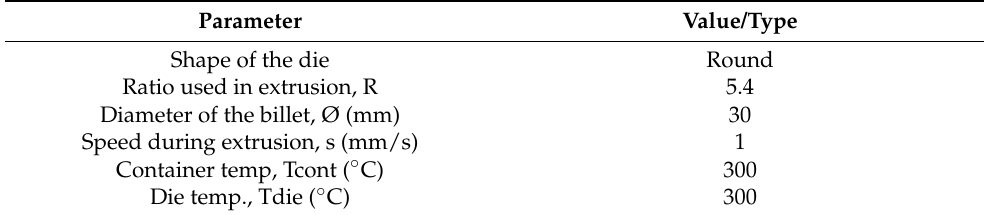
Table 5. Factors used in conducting hot extrusion.